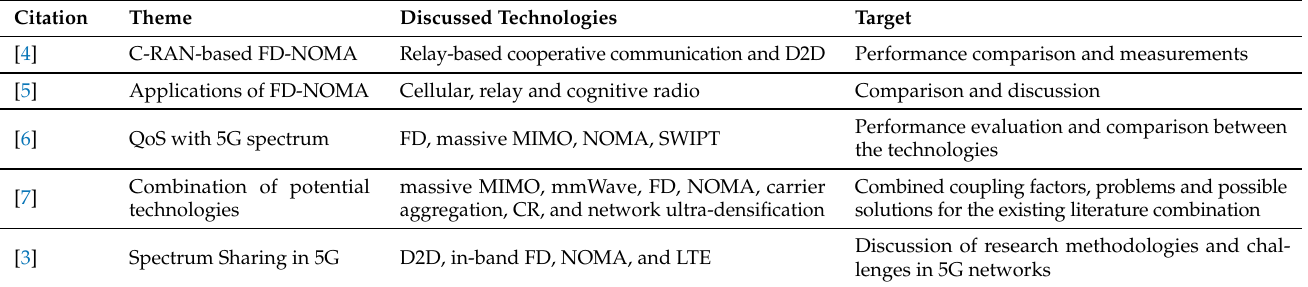
Table 1. Comparison study of existing papers that include NOMA with